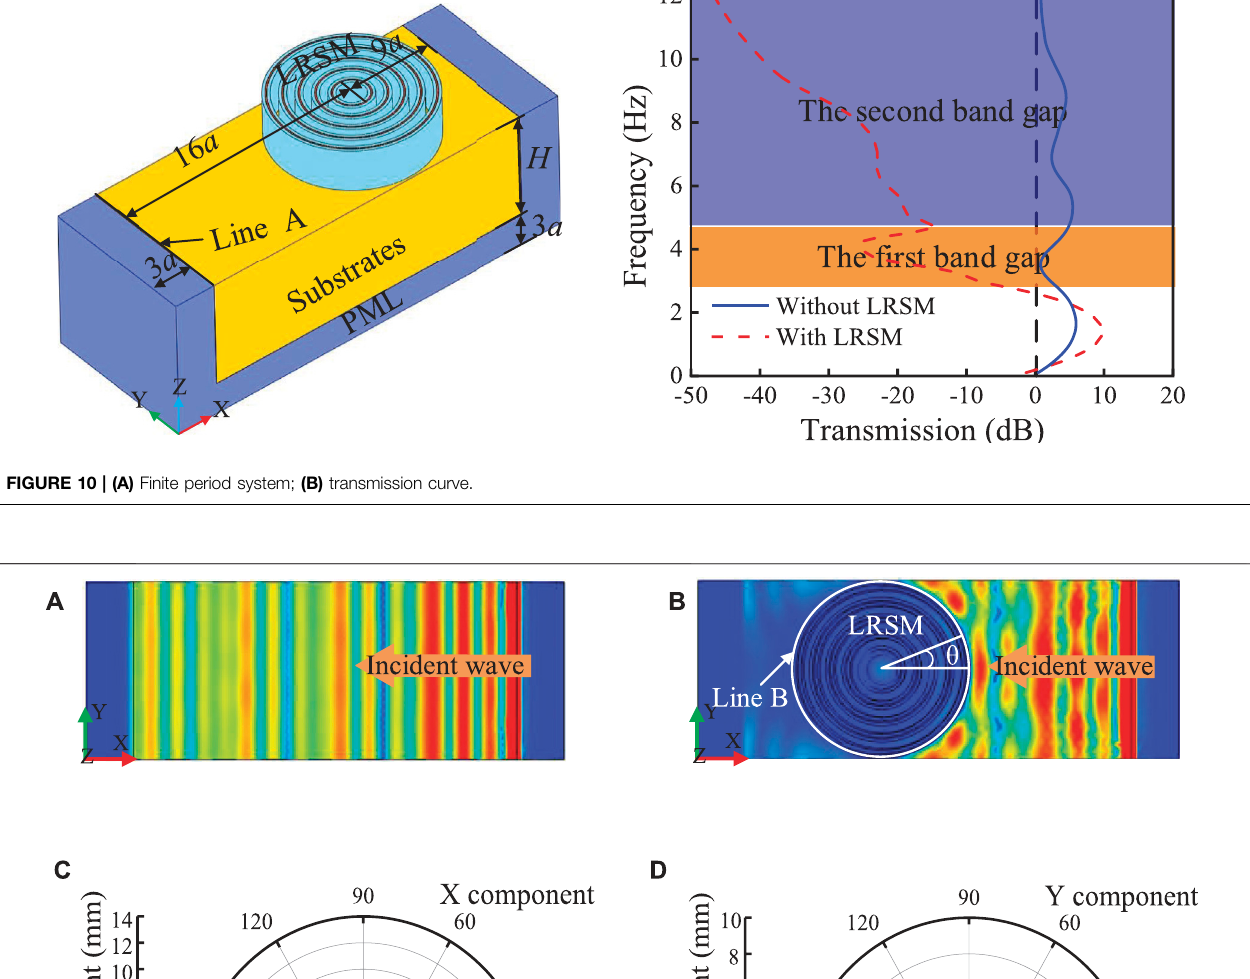
Frontiers in Materials |